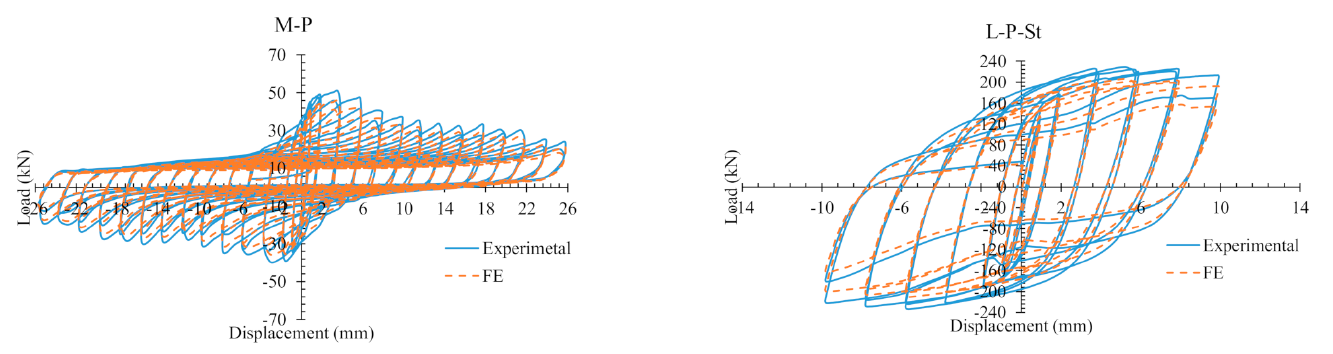
Figure 10. Comparison of experimental test results with FE